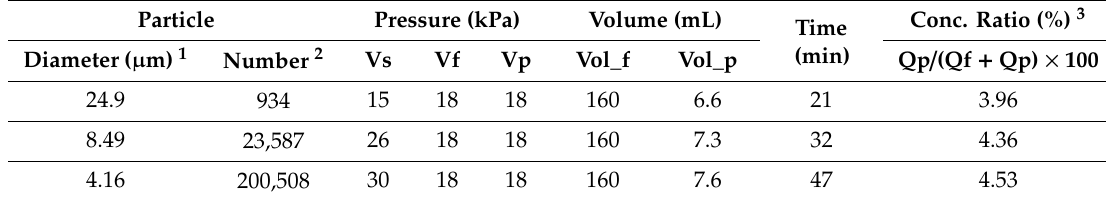
Table 3. Concentration ratios for particles of various